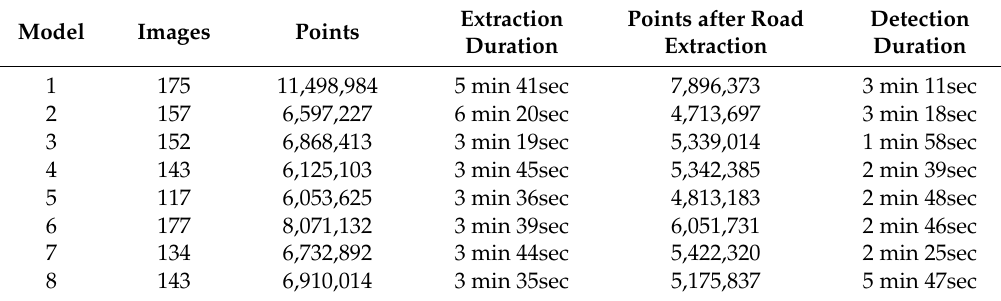
Table 10. Problem scale and time duration of the